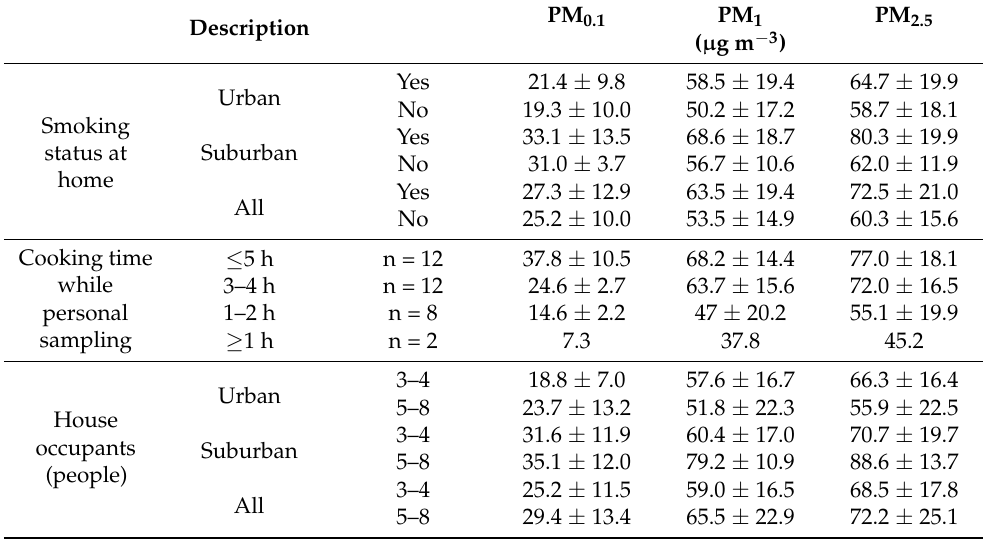
Table 7. Personal exposure to size-resolved airborne particles by the characteristics of